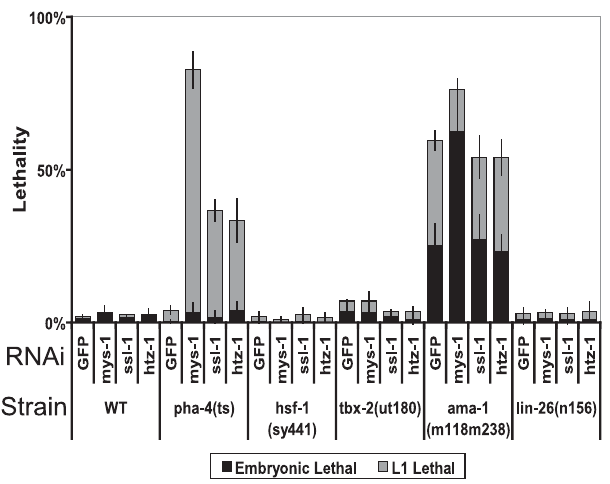
Figure 3. Specificity of mys-1, ssl-1, and htz-1 Synergy with pha-4(ts) The indicated worm strains were fed dsRNA for GFP (negative control) or mys-1, ssl-1, or htz-1 at 20 8 C (or 24 8 C for WT and pha-4(ts) ) . Lethal embryos (black bars) or lethal L1 progeny (grey bars) were scored for each strain. Effectiveness of RNAi feeding was manifest through viable, but sterile, progeny for mys-1 and ssl-1 [14], as well as repeated enhancement of L1 lethality for pha-4(ts). n ¼ 1 00 worms/plate, three plates per column. Error bars indicate the standard deviation. DOI: 10.1371/journal.pgen.0020161.g003